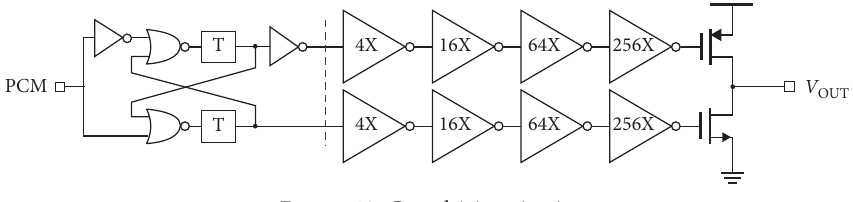
Figure 13: Gate-driving